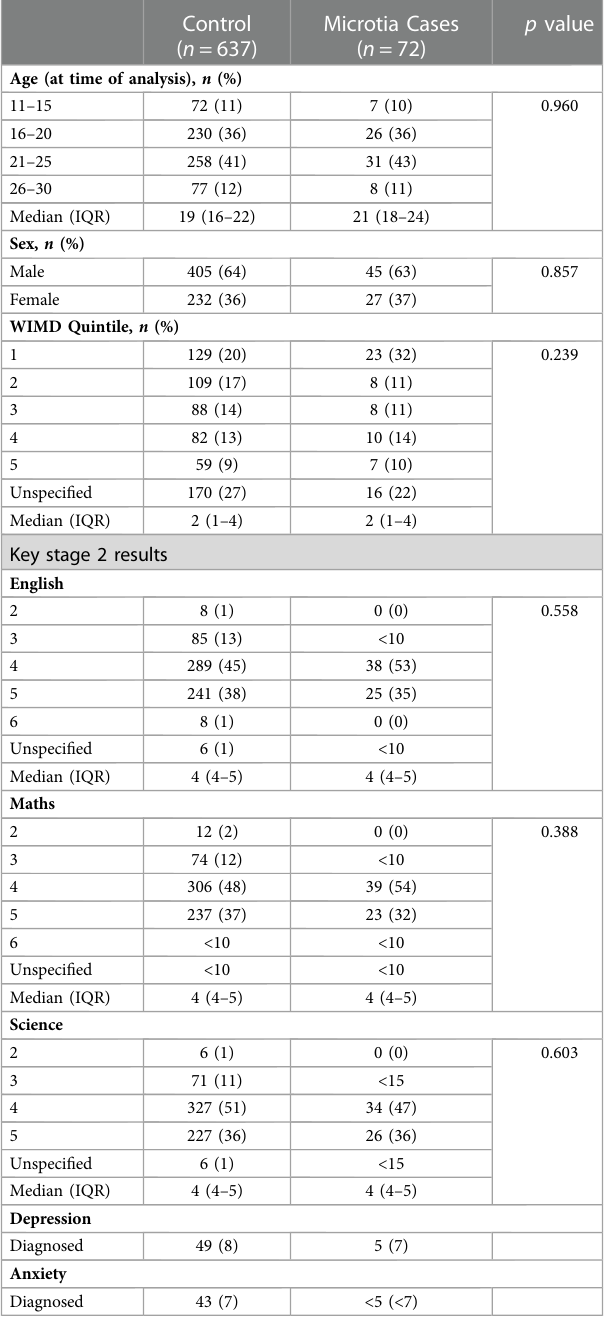
TABLE 2 Demographics of case and control populations at the time of analysis (Jan